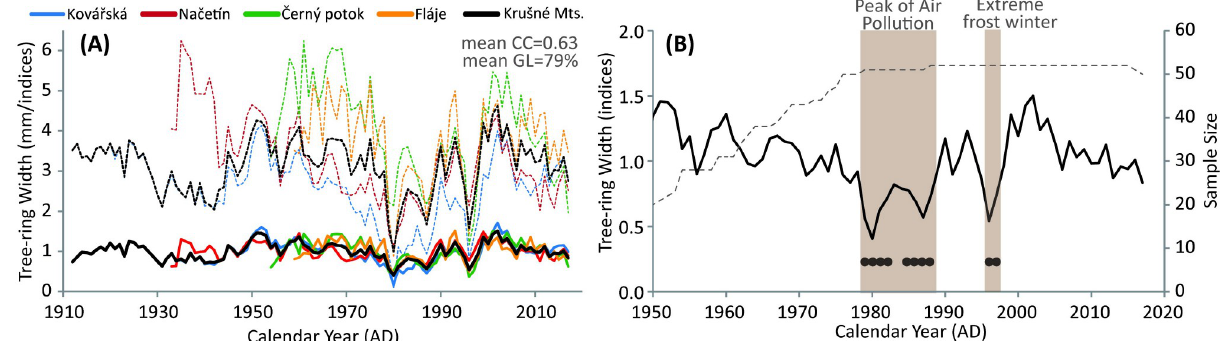
Fig 9. (A) Raw (dotted line) and standardised (full line) TRW chronologies of all individual sites as well as Ore (Krusˇne´) Mts. Mean correlation coefficient (CC) and mean GL (Gleichla¨ufgkeit; Eckstein, Bauch 1969) indicate similarity among the site chronologies. (B) Indexed mean TRW chronology for Ore Mts. truncated for sample size (dotted line) of at least 20 TRW series. Black dots indicated negative